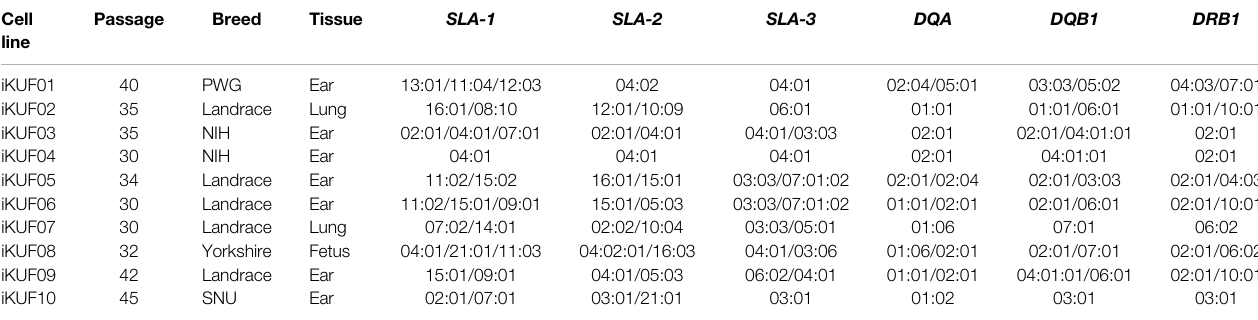
TABLE 1 | High-resolution typing results of six SLA genes for 10 immortalized fi broblast cell lines. Cell